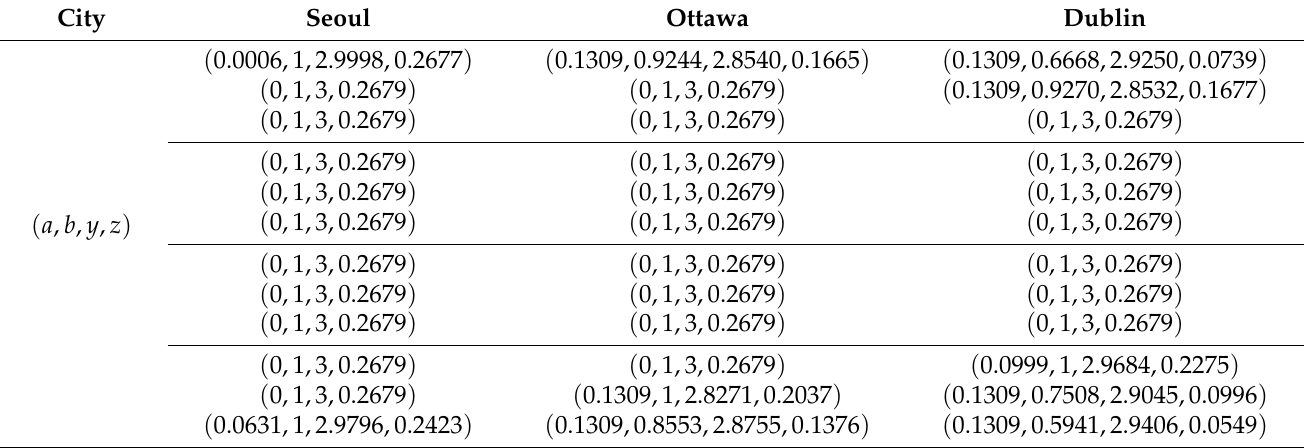
Table 1. Installation specification with respect to the south meridian altitude of each city. The azimuth angle is 73 π /72. Note that the data is aligned by month from the top (January) to the bottom